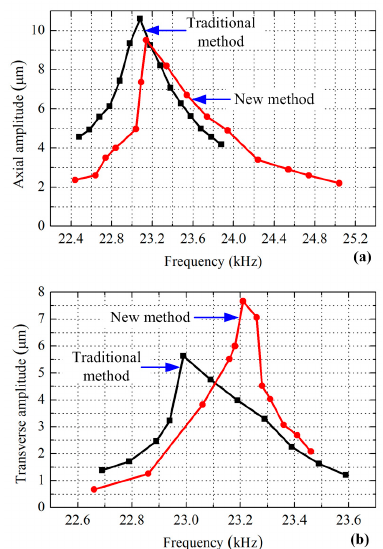
Figure 8. Comparison of the tested vibration amplitudes of the driving tip between different exciting methods: ( a ) axial amplitude under longitudinal vibration; ( b ) transverse amplitude under bending vibration.